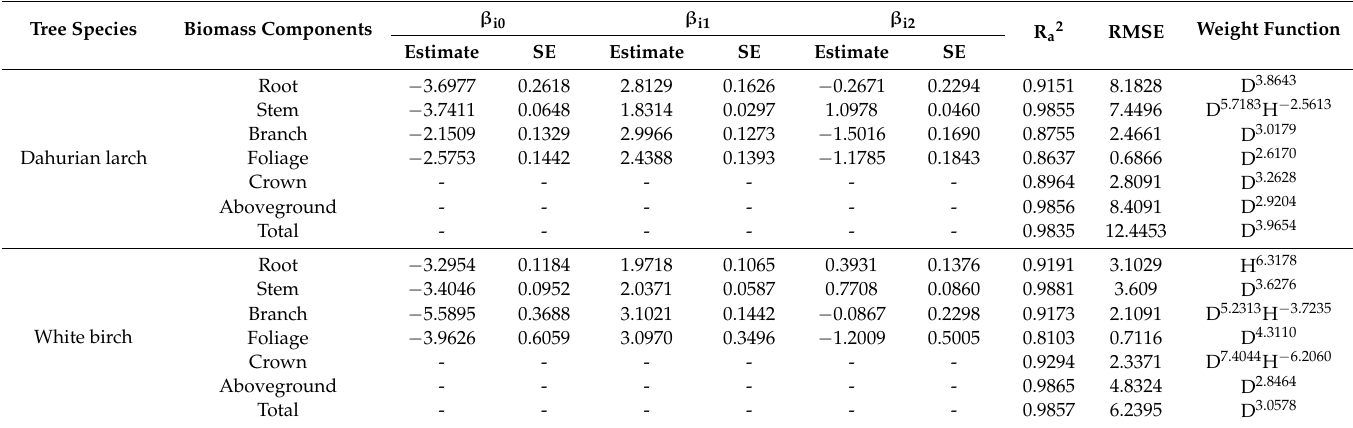
Table 6. Model coefficient estimates, standard errors, goodness-of-fit statistics, and weight functions for the additive system of biomass equations based on two predictors (D and H, namely MS-3).